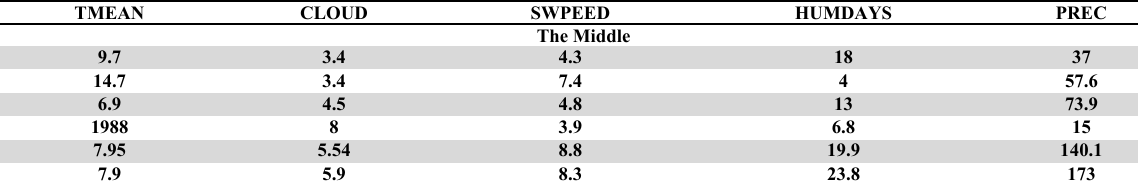
Fig. 2. The seasonal rainfall rate of Amman (Middle region stations) for period between 1989 and 2020 Sample of dataset for middle region in